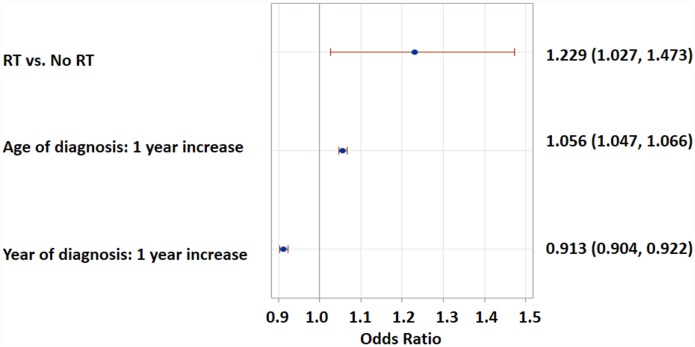
Multivariate logistic regression analysis of the probability of cardiac death by RT, adjusted by age at diagnosis and diagnosis year.